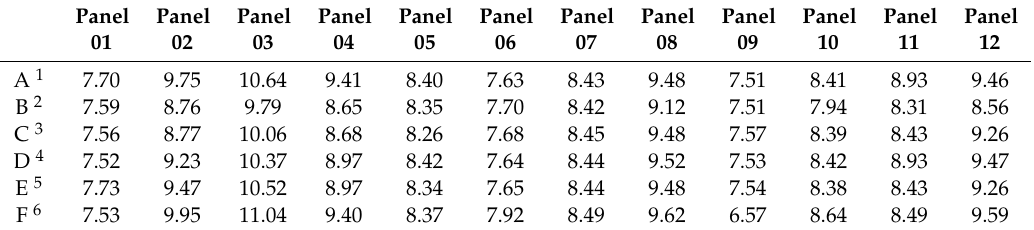
Table 2. The average of kriging predictions and borehole data for each